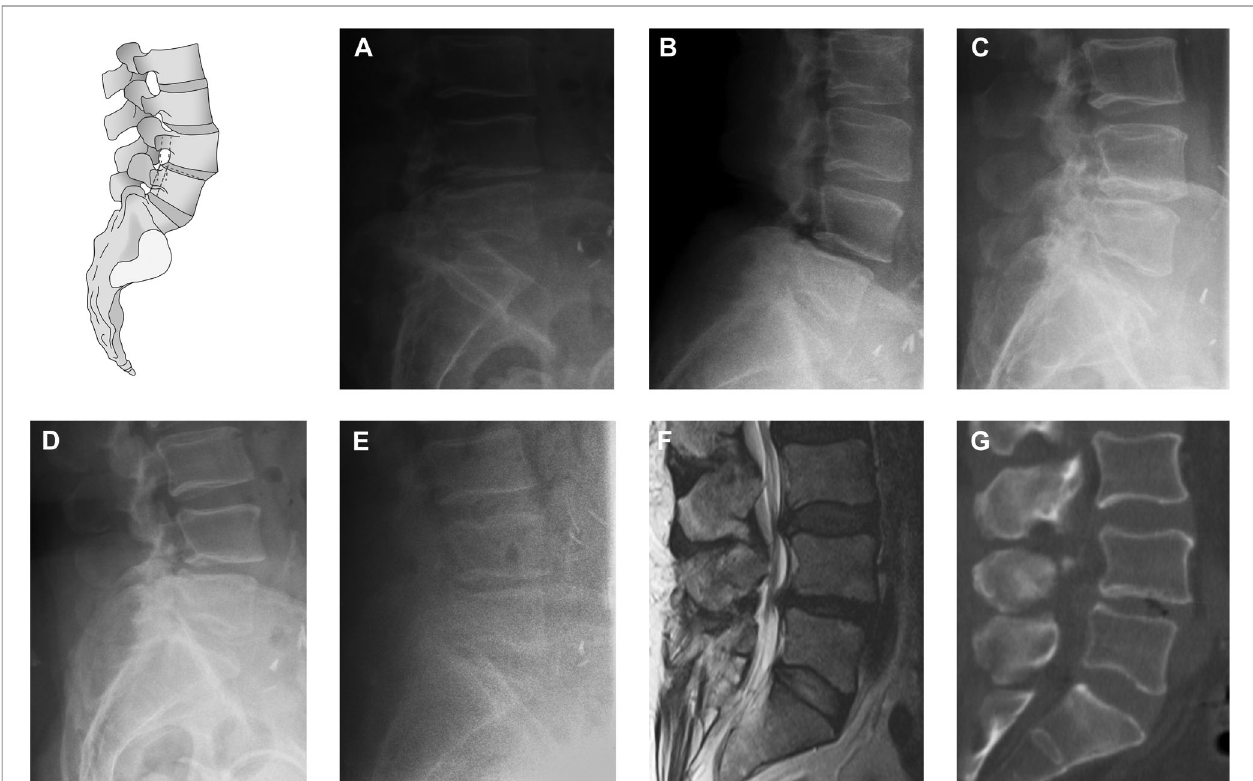
FIGURE 1 | Comparisons of different imaging modalities. Sagittal translation was measured as indicated in the given pictogram. Slump siting ( A ), inclination ( B ), neutral ( C ), reclination ( D ), prone ( E ), MRI ( F ), and CT ( G